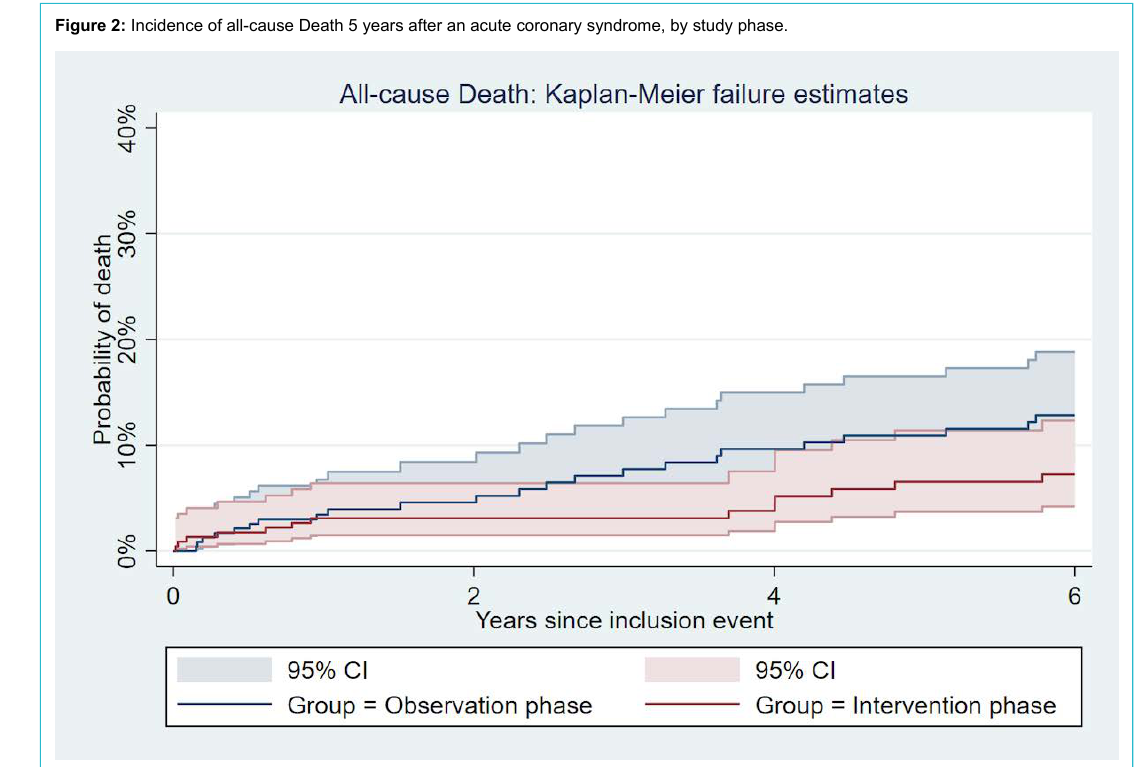
Figure 2: Incidence of all-cause Death 5 years after an acute coronary syndrome, by study